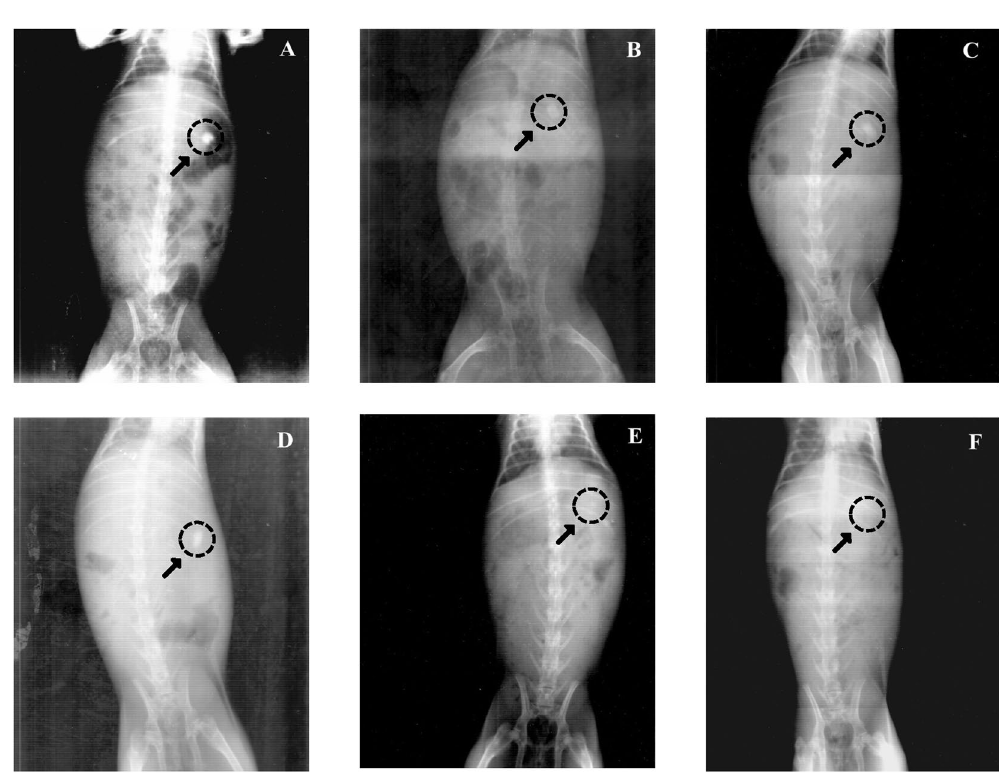
Figure 5. A-F X-rays indicating the positions of the BaSO 4 -labeled DOM-FSR tablets in the gastrointestinal tract of New Zealand rabbits at different time points. X-rays taken at ( A ) 2 h, ( B ) 4 h, ( C ) 6 h, ( D ) 8 h, ( E ) 10 h, and ( F ) 12